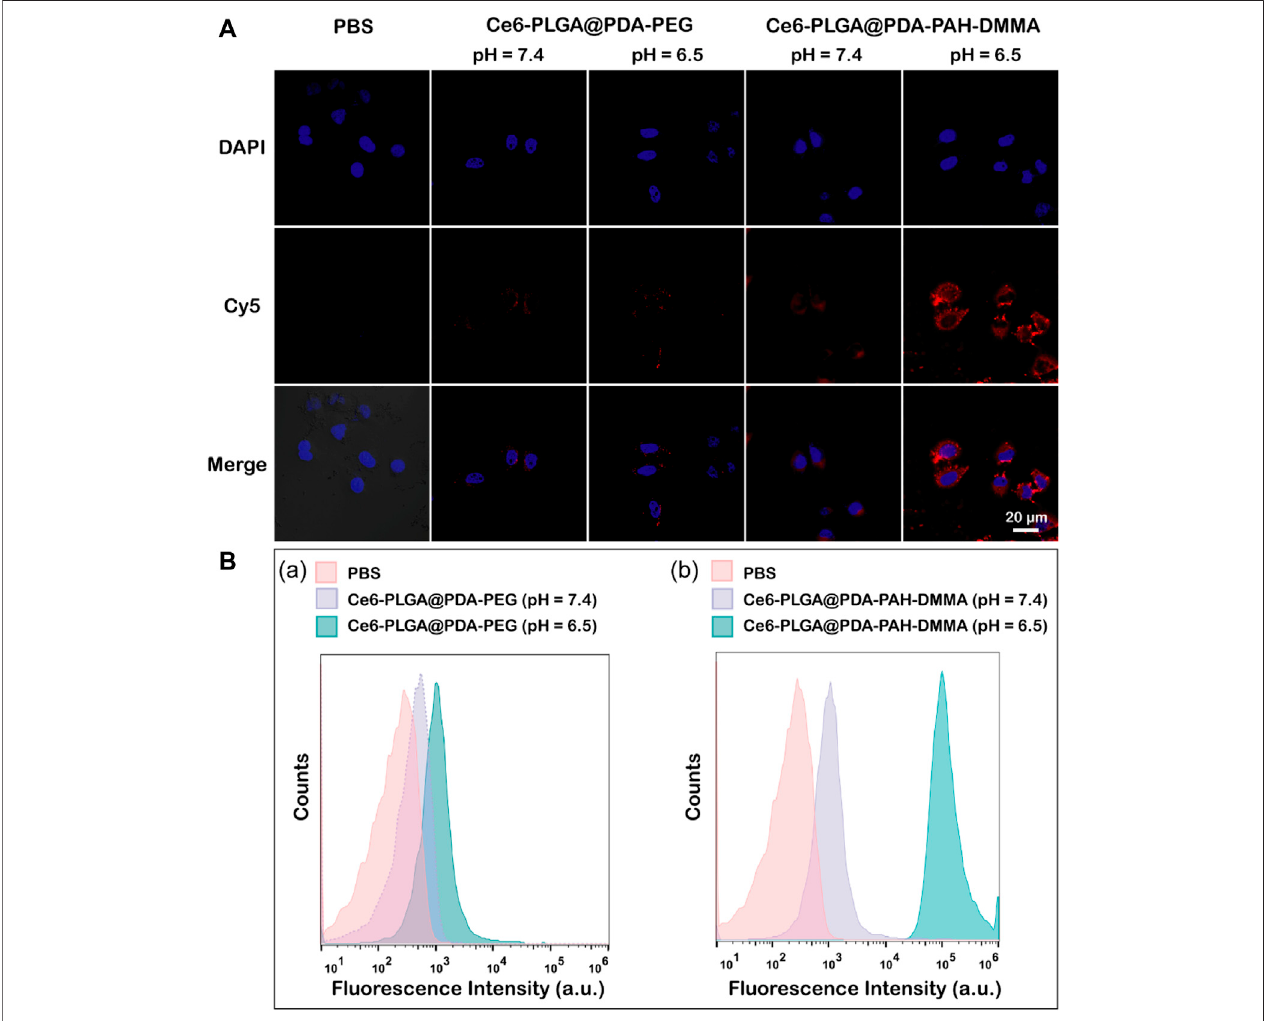
FIGURE 4 | (A) Confocal images of MCF-7 cells cultured separately with the NPs at pH 7.4 and 6.5 for 2 h at 37 ° C (Blue: DAPI; Red: Cy5 fl uorescence). (B) Flow cytometric analysis of MCF-7 cells after treating with Ce6-PLGA@PDA-PEG NPs (A) and Ce6-PLGA@PDA-PAH-DMMA NPs (B) at pH 7.4 and